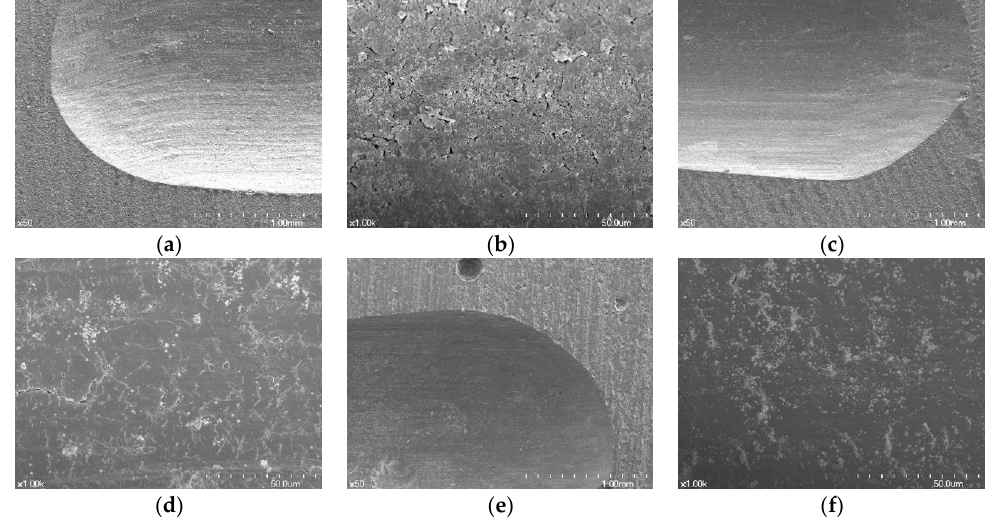
Figure 5. SEM images of the worn surfaces of the materials against the zirconia abrader. ( a ) 3D printed resin (original magnification ×50); ( b ) 3D printed resin (original magnification ×1000); ( c ) milled resin (original magnification ×50); ( d ) milled resin (original magnification ×1000); ( e ) self-cured resin (original magnification ×50); ( f ) self-cured resin (original magnification ×1000).